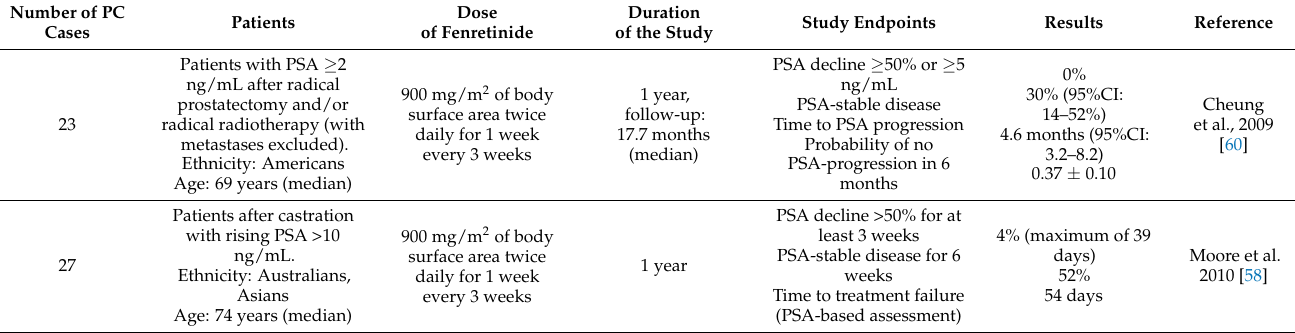
Table 2. Summary of clinical studies that investigated the effectiveness of fenretinide in the treatment of PC (published between 2009 and